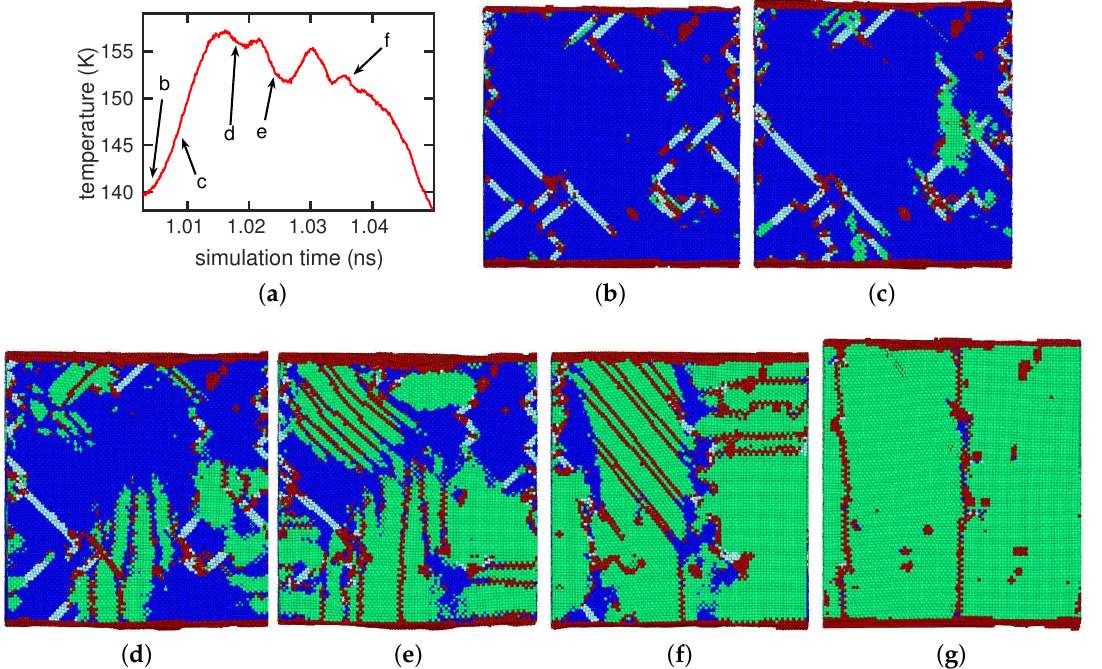
Figure 8. Martensitic transformation process in a sample with a dislocation density of ρ = 10.34 × 10 12 cm − 2 . ( a ) The temporal evolution of the sample temperature during the martensitic transformation; the times of the snapshots ( b – f ) are marked in ( a ); ( g ) the final state after completion of the transformation. The colors denote the local lattice structure as in Figure